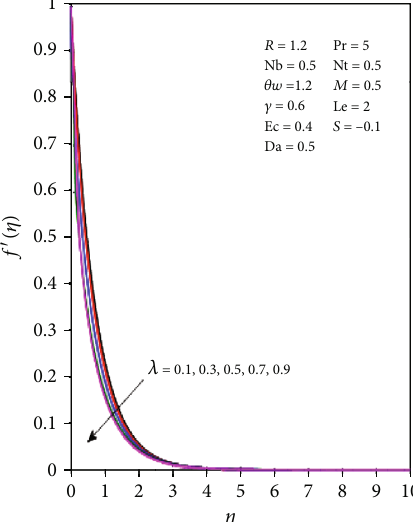
Figure 3: The velocity pro fi le for di ff erent values of λ